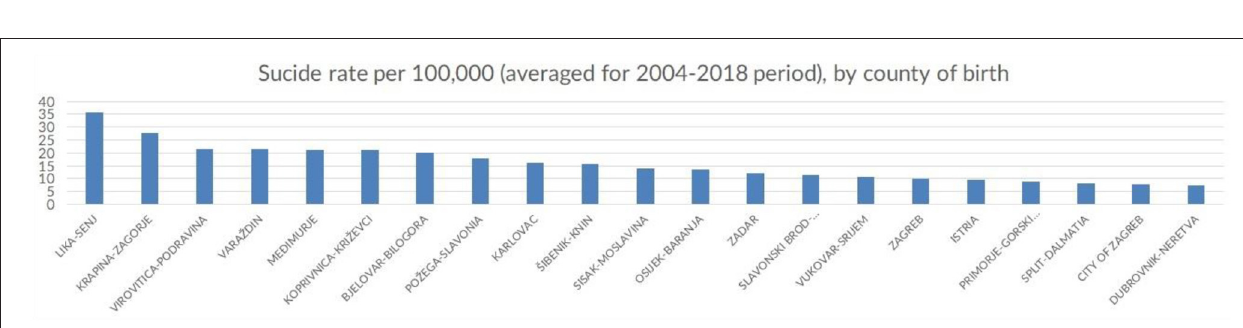
FIGURE 5 | Average number of suicide cases per month of the year, in Croatia (averaged across the observed period), 2004-2018 (Croatia, 2021).